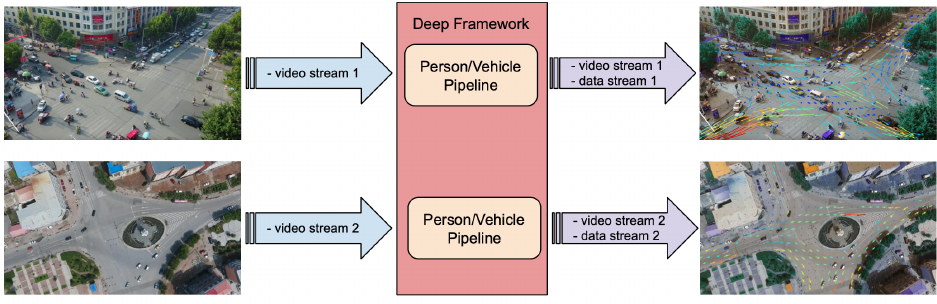
Figure 12. Example of a crowd/traffic monitoring application designed with Deep-Framework.